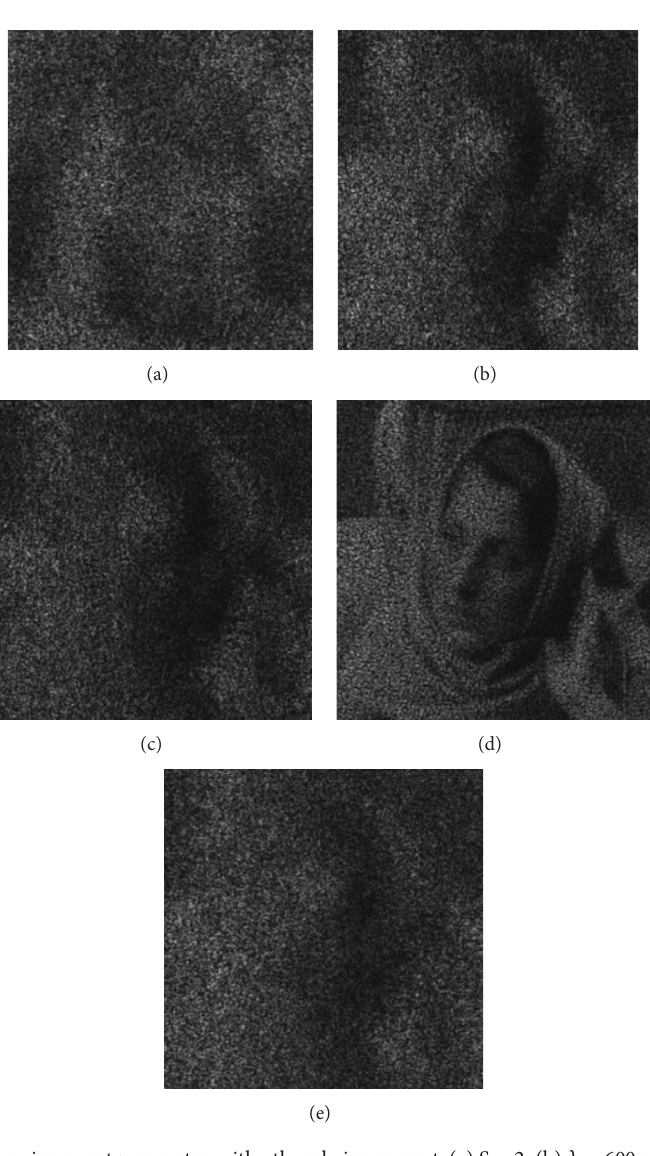
Figure 5: Decrypted image with one incorrect parameter, with others being correct. (a) 𝑆 = 2 , (b) 𝜆 = 600 nm, (c) 𝑓 = 4.5 cm, and (d) 𝑚 = 1 . (e) Decrypted image with two incorrect parameters (𝑆 = 2, 𝑚 = 1) .